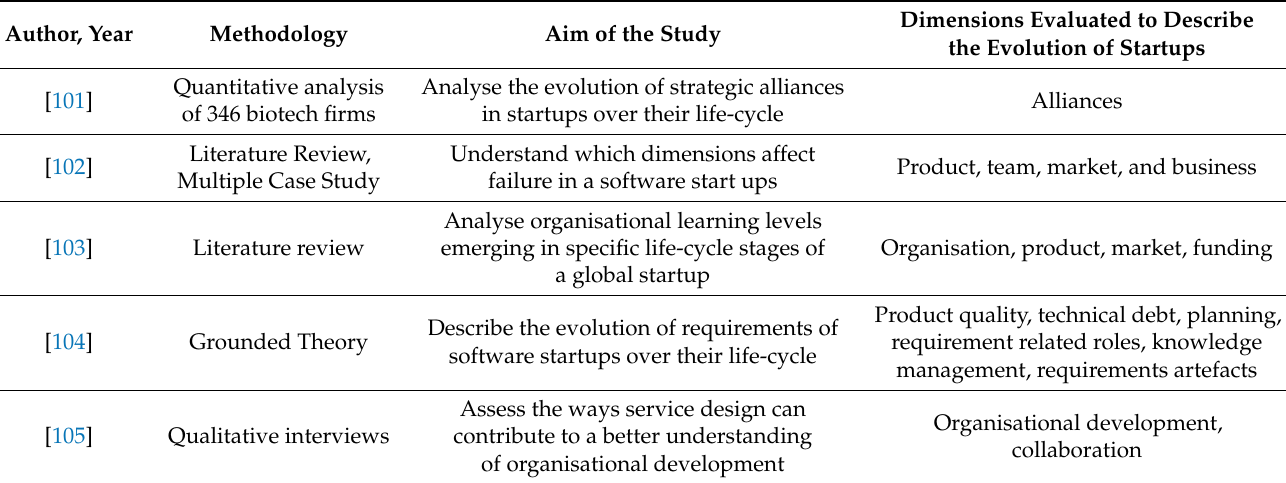
Table 4. Publications related to the framework